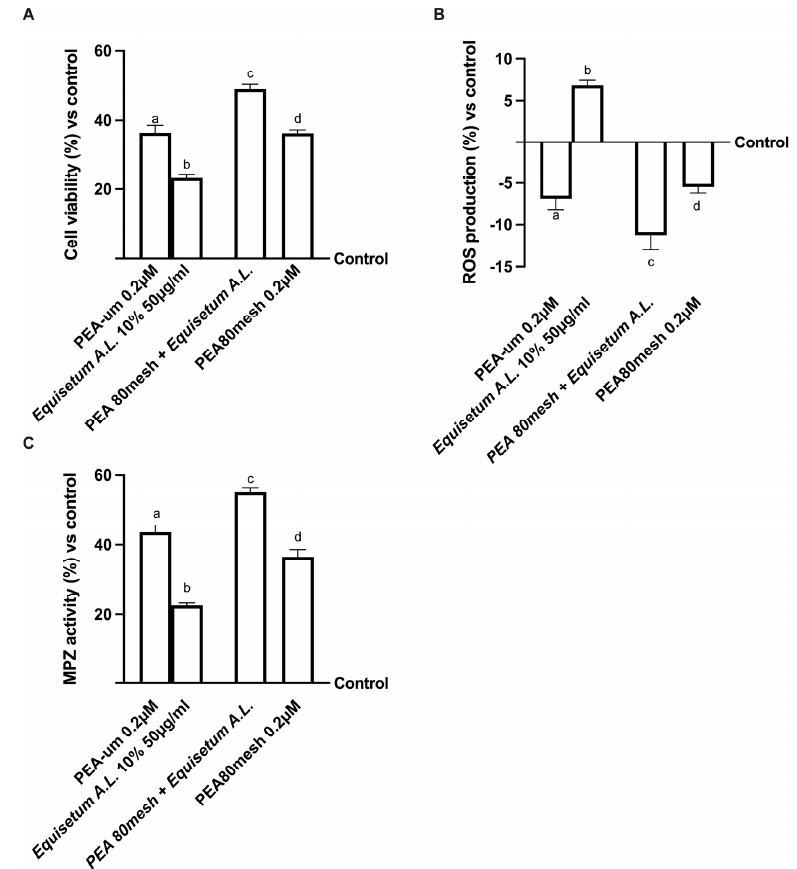
Figure 2. Analysis of EquiPEA™ on 3D EngNT in physiological conditions In ( A ) mitochondrial metabolism measured by the MTT test; ( B ) ROS production by cytochrome C reduction; and ( C ) myelin protein zero (MPZ) measured by the ELISA test. The abbreviations are the same as those reported in Figure 1. The data are the mean ± SD of five independent experiments performed in triplicate and normalized to control values (0% line). In ( A ): a–d p < 0.05 vs. control; a p < 0.05 vs. b, c, d; b p < 0.05 vs. c, d; c p < 0.05 vs. d. In ( B ): a–d p < 0.05 vs. control; a p < 0.05 vs. b–d; b p < 0.05 vs. c, d; c p < 0.05 vs. d. In ( C ): a–d p < 0.05 vs. control; a p < 0.05 vs. b, c, d; b p < 0.05 vs. c, d; c p < 0.05 vs. d.